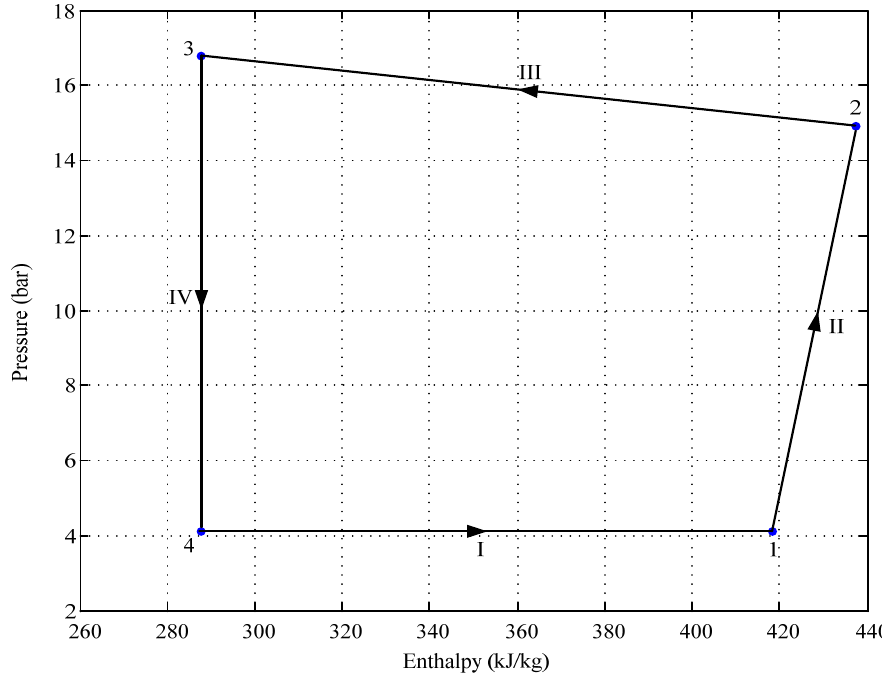
Figure 4. Pressure-enthalpy diagram of the PVTA-HPWH